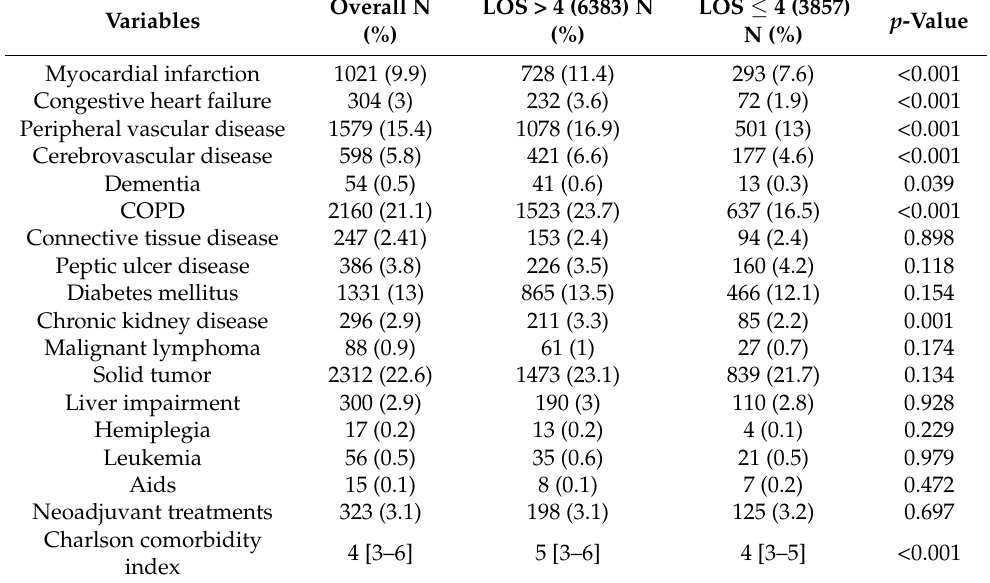
Table 2. Patient’s preoperative comorbidities.